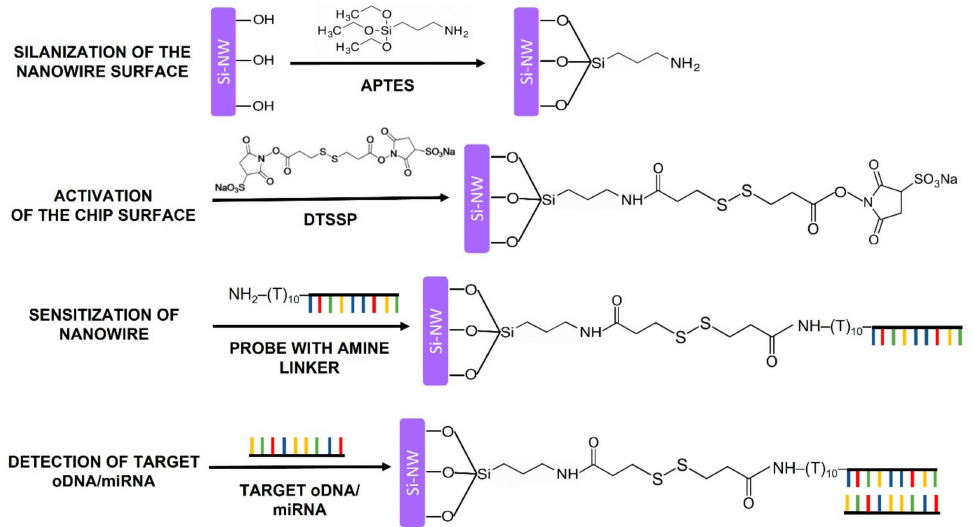
Figure 5. A schematic representation of the principle of the functionalization of the sensor surface. The functionalization comprised chemical modification and sensitization of the SOI-NW chip surface, which were performed in order to provide reliable detection of the target